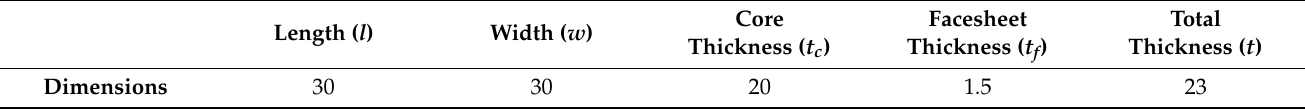
Table 1. Geometrical parameters of the sandwich structures (units: mm).